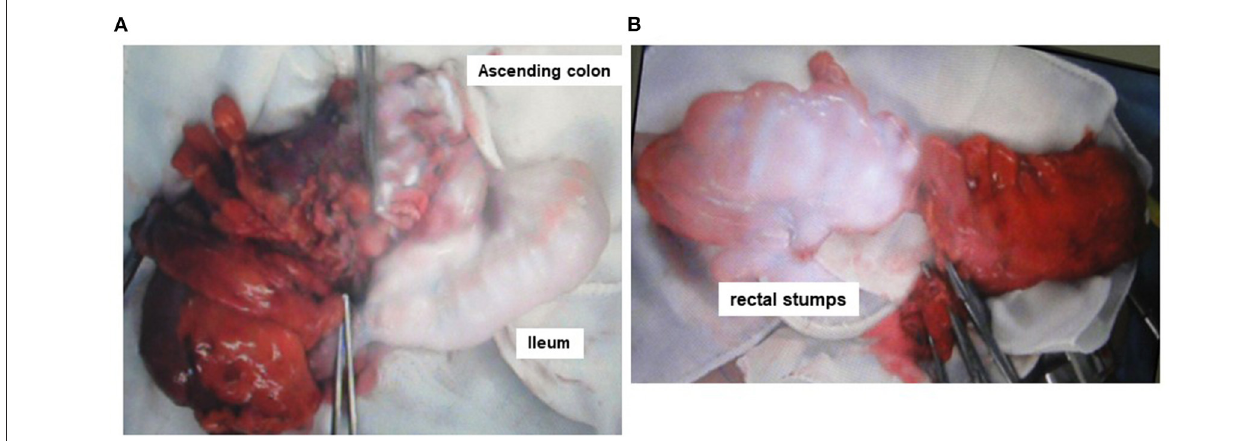
FIGURE 1 | Intraoperative images of (A) ileocecal resection and (B) anterior rectal resection.